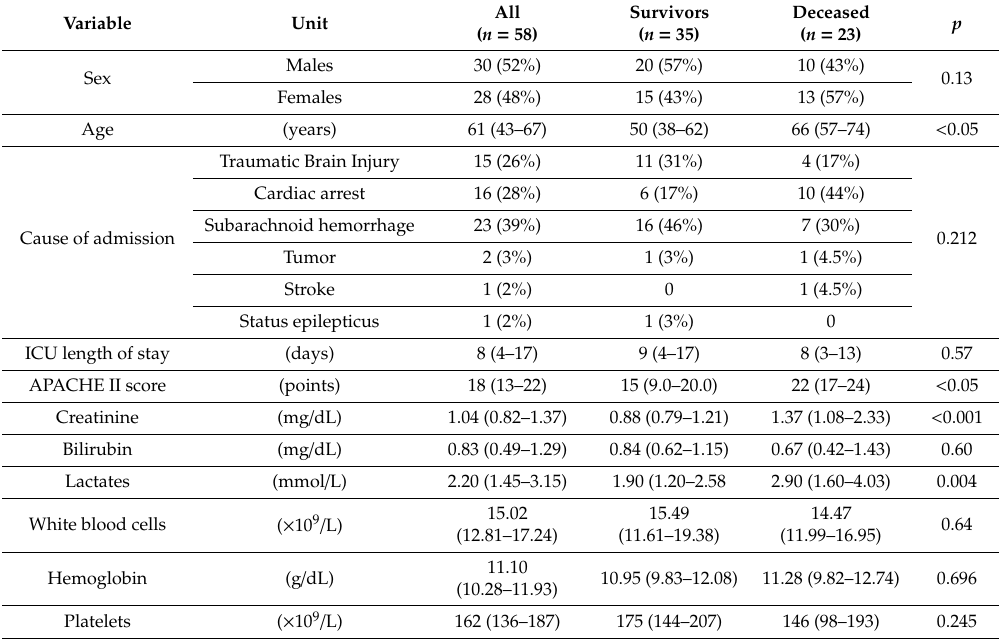
Table 1. Study group characteristics and procedure-related variables 1 .